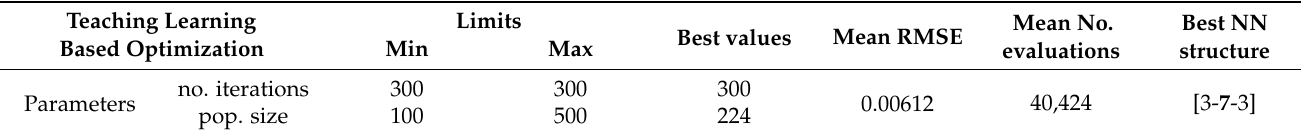
Table A5. The best results provided by the search procedure for the Teaching Learning Based Optimization